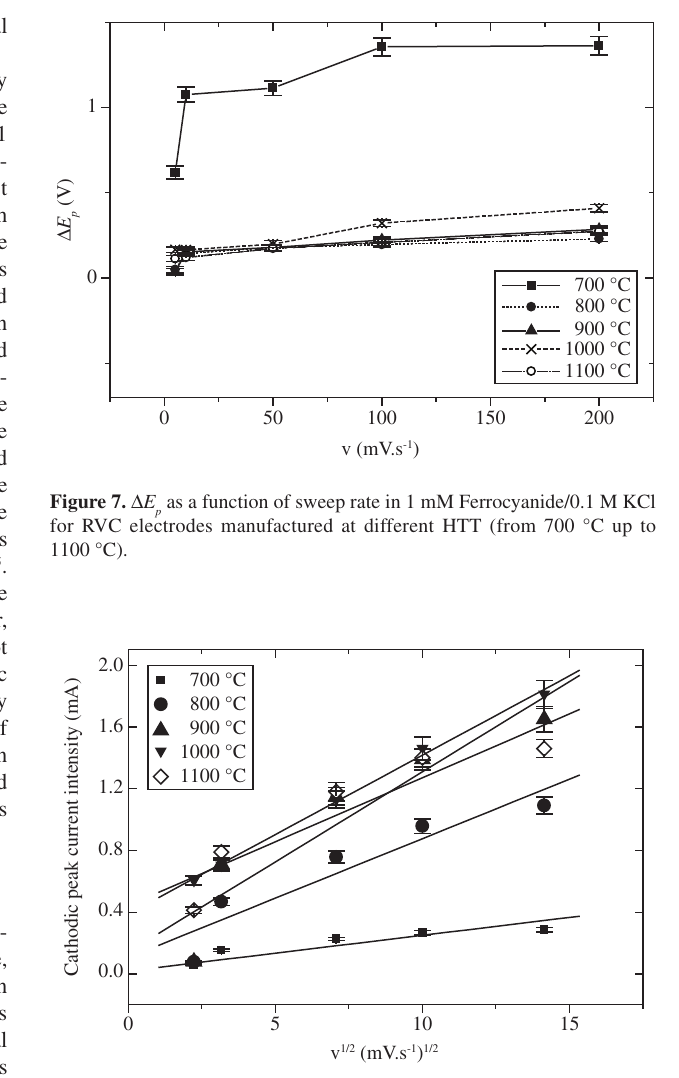
Figure 8. Cathodic peak current as a function of (sweep rate) 1/2 in 1 mM Ferrocyanide/0.1 M KCl for RVC electrodes manufactured at different HTT (from 700 °C up to 1100 °C).